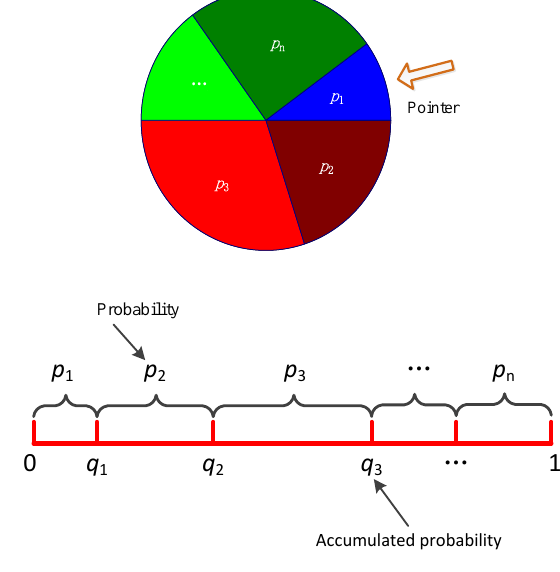
Figure 4. Roulette selection diagram.